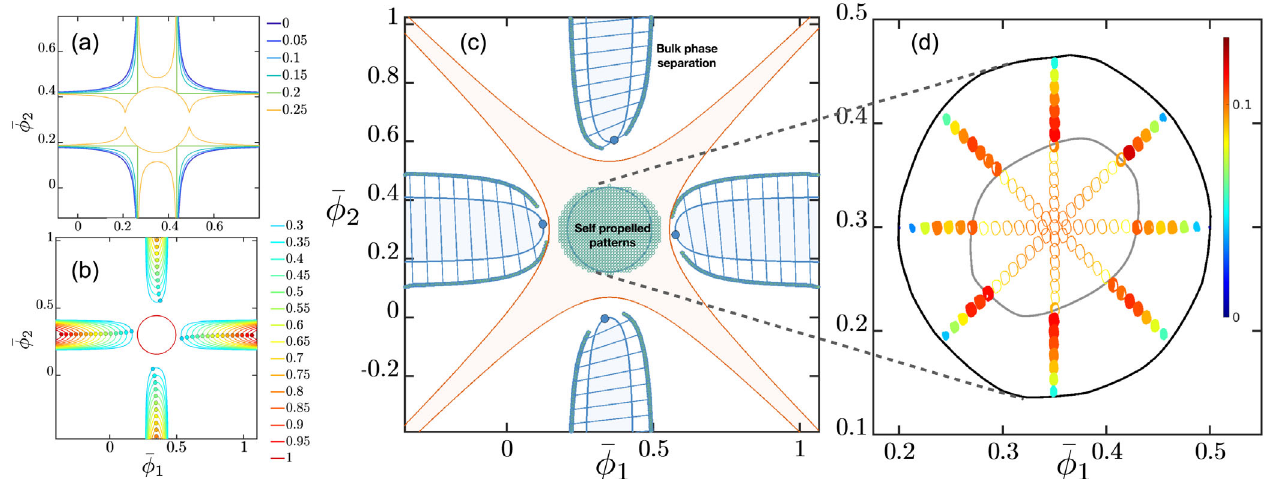
FIG. 6. Phase diagrams for pattern formation in the NRCH model. The spinodal region determined from the linear stability analysis is shown in panels (a) and (b) for the values of α shown in the legend. (a) Spinodals for low α . (b) As the activity is increased beyond α ≳ j χ j , the topology of the curves consists of four arms surrounding a central circular region. (c) Phase diagram in the plane of average ¯ ϕ ; ¯ ϕ α ¼ 0 . 4 . Bulk phase separation (four blue arms) and pattern formation (turquoise inner circle) occur in the composition ð 1 2 Þ for same phase diagram. (d) Magnification of the inner circle. The gray line encloses the region where self-propelled lamellar patterns are observed [see Figs. 1(e) – 1(g)], with a constant wavelength and an amplitude that decays slowly on moving away from the center of the oscillatory region. Within this region, ½ ϕ 1 ð r ; t Þ ; ϕ 2 ð r ; t Þ(cid:2) evolve towards a limit cycle independent of r at all spatial points, as described in Sec. IV B. The changes in the limit cycles upon moving radially along the composition plane are depicted by plotting a scaled-down version of Fig. 4(c) at selected points in a few radial directions. The area of the limit cycle decreases towards the edge of this region; the color encodes the area of the limit cycle and varies as shown in the color bar. In the region between the gray and black curves, the steady state changes to a lattice of local density undulations, which moves with a constant velocity [see Figs. 1(h) – 1(l)]. The trajectories change from simple limit cycles to complex repeating patterns. This complexity is reflected in the more complex phase portrait as seen in the scaled-down version plotted in the region between the gray and black boundaries. Parameters for the free energy are as in Fig. 1. The system size of 201 × 201 is used in all of the simulations here, with a time step of 10 − 4 for panel (c) and an increased time stepping of 10 − 3 for the simulations corresponding to panel